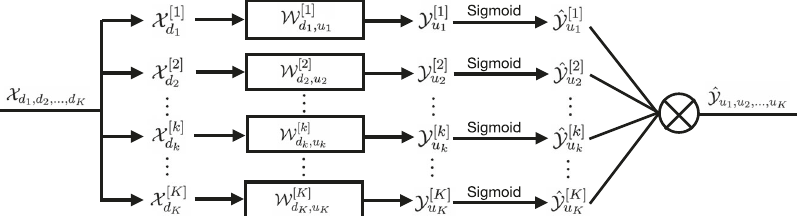
Fig. 4 Reformulating the TTN model in a parallel structure. Each element of the input K -order tensor X d by utilizing TTD. Each X ½ k (cid:8) goes through the TTN associated with model parameters W ½ k (cid:8) . The sigmoid function is imposed upon the X d d k k output Y ½ k (cid:8) , and all Y ½ k (cid:8) are all multiplied to form the output ^ Y u u k u k